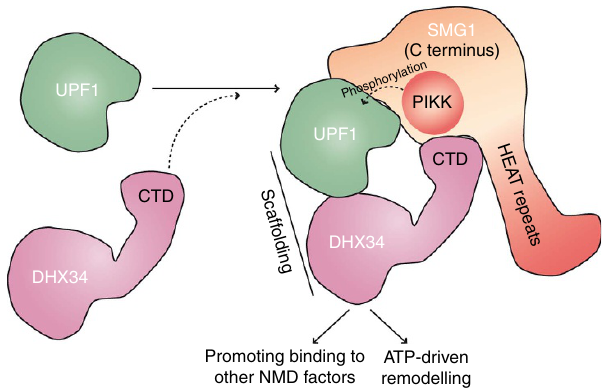
Figure 7 | Molecular model for the function of DHX34 in NMD. DHX34 functions as a scaffold for UPF1 and SMG1, bringing the two proteins in the right orientation and placing UPF1 facing the SMG1 kinase domain. The CTD domain in DHX34 is essential for holding the SMG1-UPF1-DHX34 complex together. DHX34 could also contribute to UPF1 phosphorylation by facilitating the interaction of UPF1 with other NMD factors and the ATP- driven remodelling of the NMD